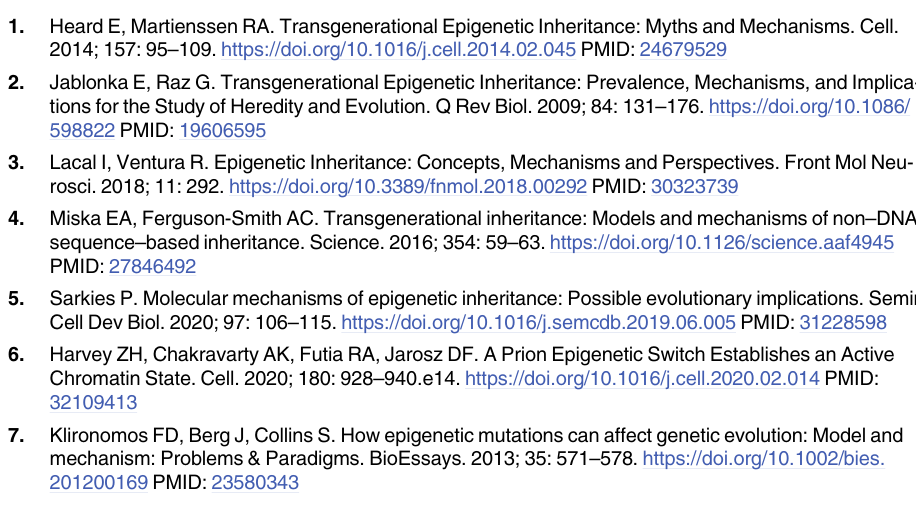
S53 Table. Table of values for gene expression used in S8 Fig File name: S53_Table.csv.